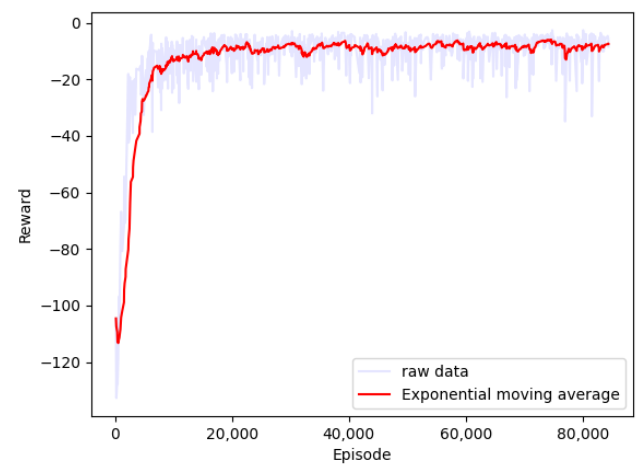
Figure 12. Experiment: reward of the proposed path planning in